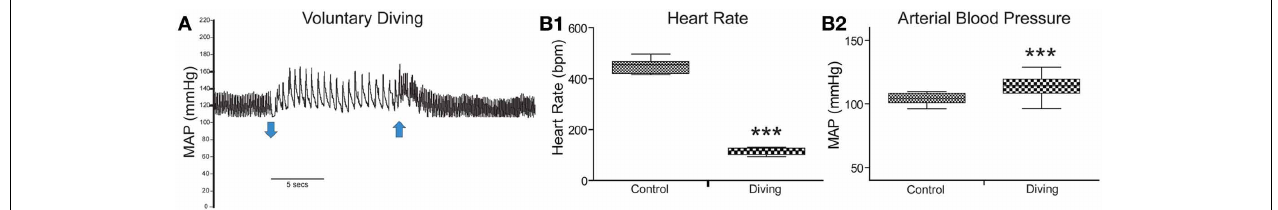
FIGURE 1 | Cardiovascular responses to underwater submersion of voluntarily diving rats. The abrupt bradycardia and increase in mean arterial pressure (MAP) is seen in (A) upon submergence (down arrow), which immediately reverts to normal rhythms after emergence from the water (up